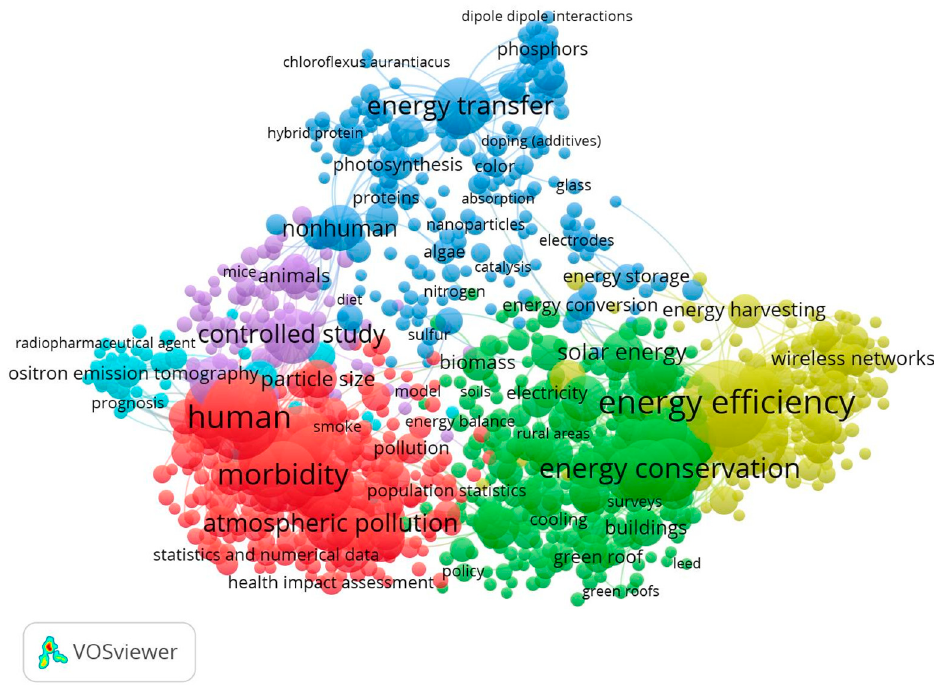
Figure 5. A visualisation map of the co-occurrence analysis (source: developed by the author based on Scopus and VOSviewer).